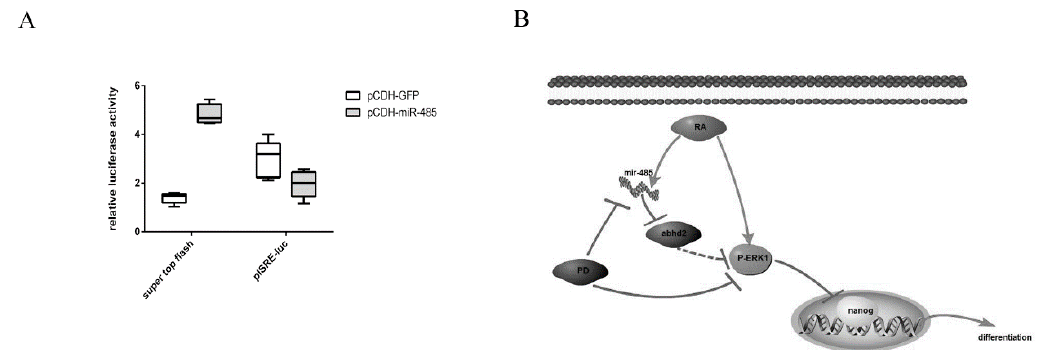
Figure 6. ( A ) miR-485 is involved in Wnt and JAK/STAT pathway. Pathway reporter luciferase vector pISRE-luc and super top flash and internal control pRL-SV40 were co-transfected with pCDH-GFP and pCDH-miR-485 into F9 ECs for 36 h. Luciferase activity was presented relative to negative control pTA-luc. Data are presented as the mean ± SD of six independent experiments. ( B ) Schematic diagram of the RA-induced cell differentiation by ERK1/2.